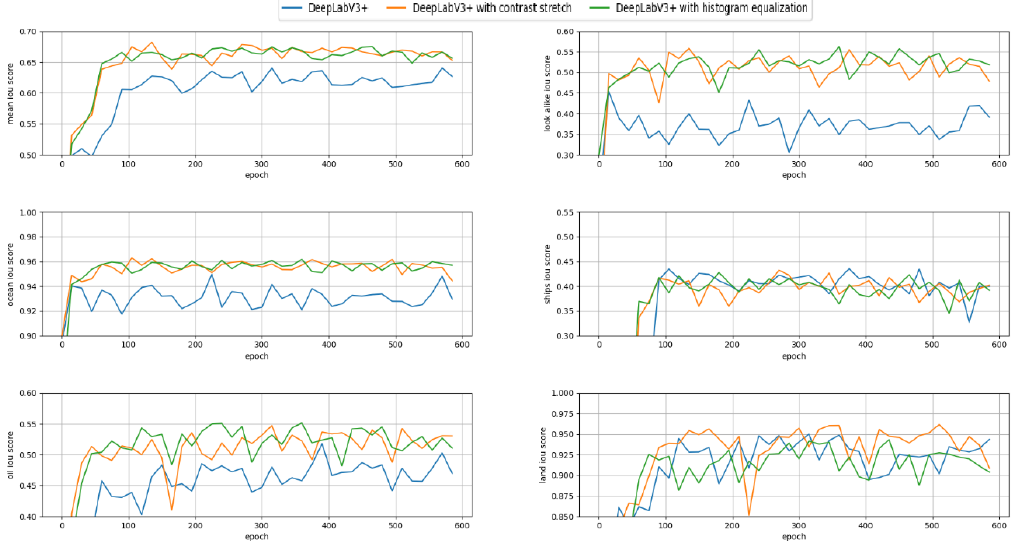
Figure 9. Test set IoU scores of the models utilizing the DeepLabv3+ architecture, measured every 25 epochs.